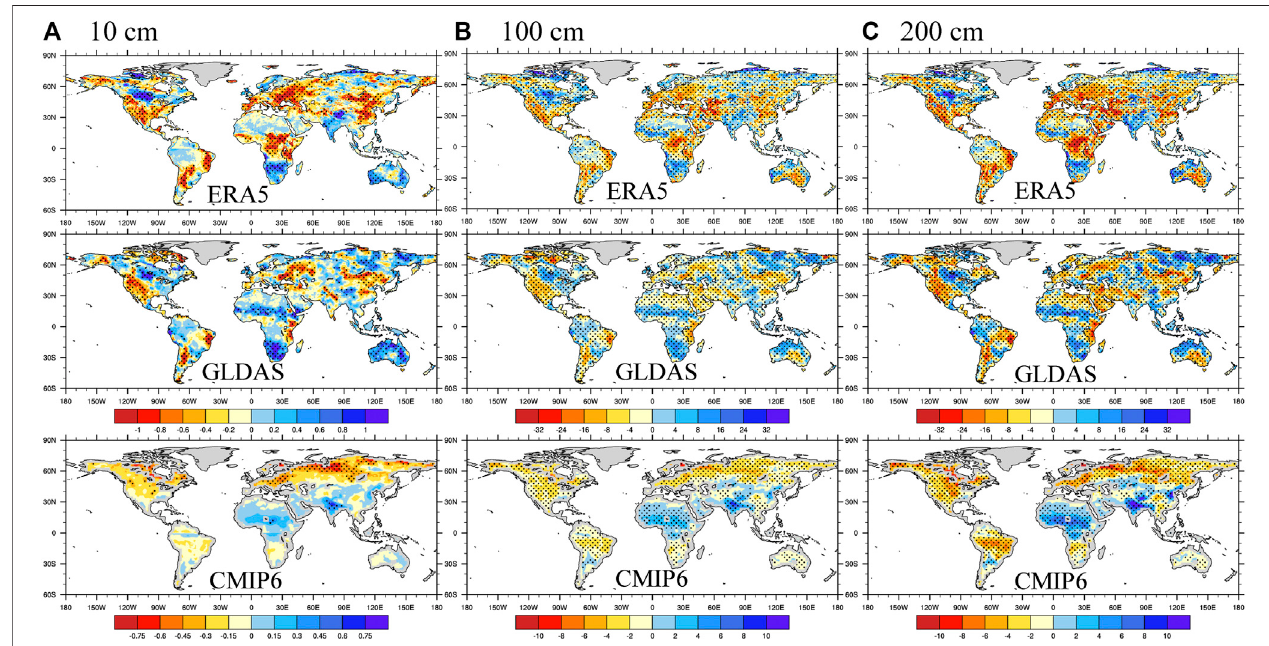
FIGURE 1 | Spatial distribution of the soil moisture trend (kg/m 2 /decade, 1979 – 2014) in different datasets in summer (the Northern Hemisphere is averaged in June, July, and August, and the Southern Hemisphere is averaged in December, January, and February). (A) , (B) , and (C) Shallow (10 cm), middle (100 cm), and deep (200 cm) soil moisture, respectively. Black dots indicate where a given area passes the 90% signi fi cance test.